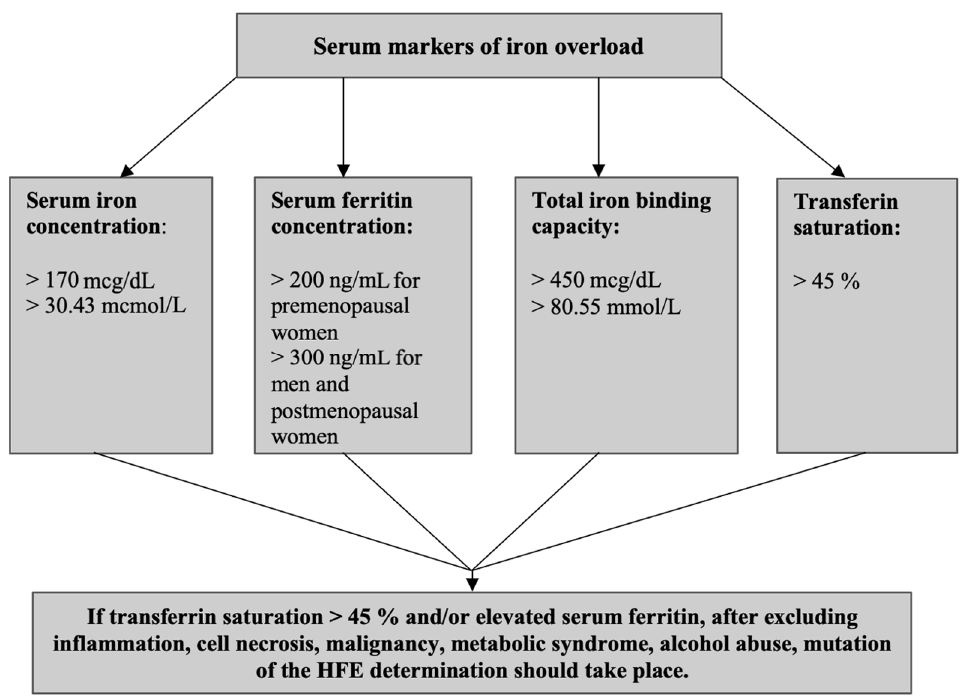
Figure 1. Diagnostic algorithm for iron overload diseases.